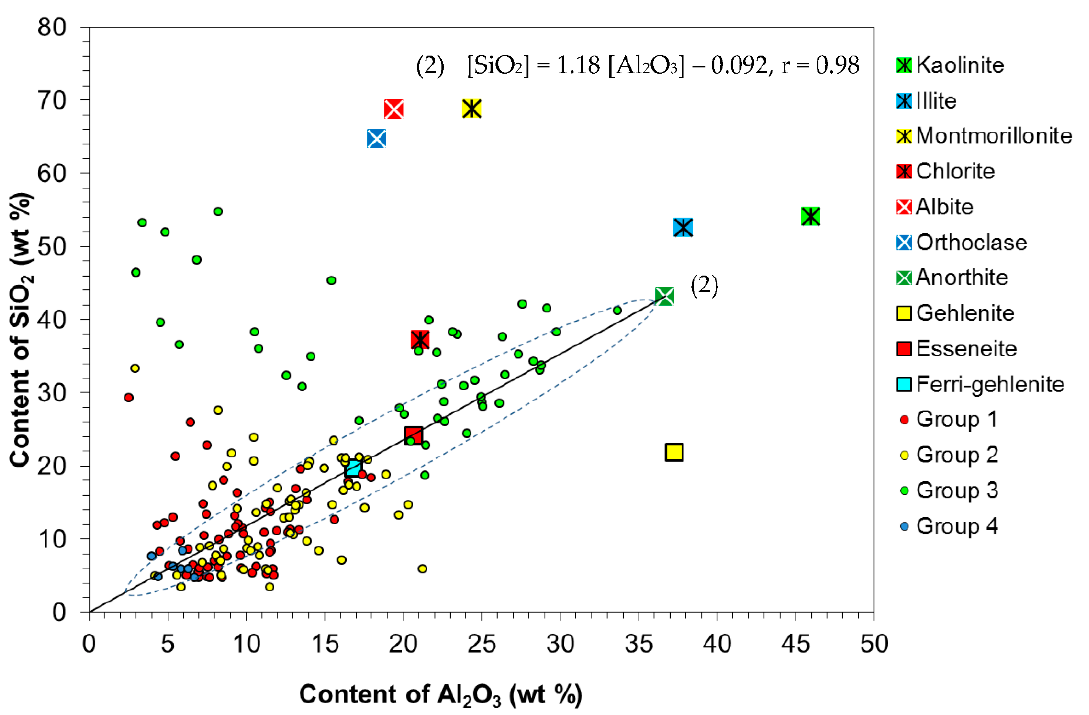
Figure 6. The SiO 2 content as a function of the Al 2 O 3 content for individual microspheres PM 1-2 . Compositions of dehydroxylated minerals and compounds correspond to their stoichiometric formula.